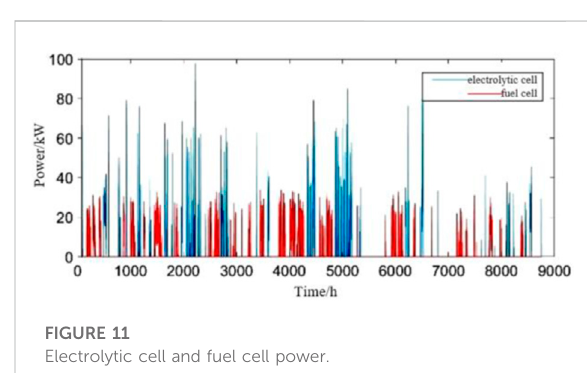
FIGURE 13 The system is short of power at different